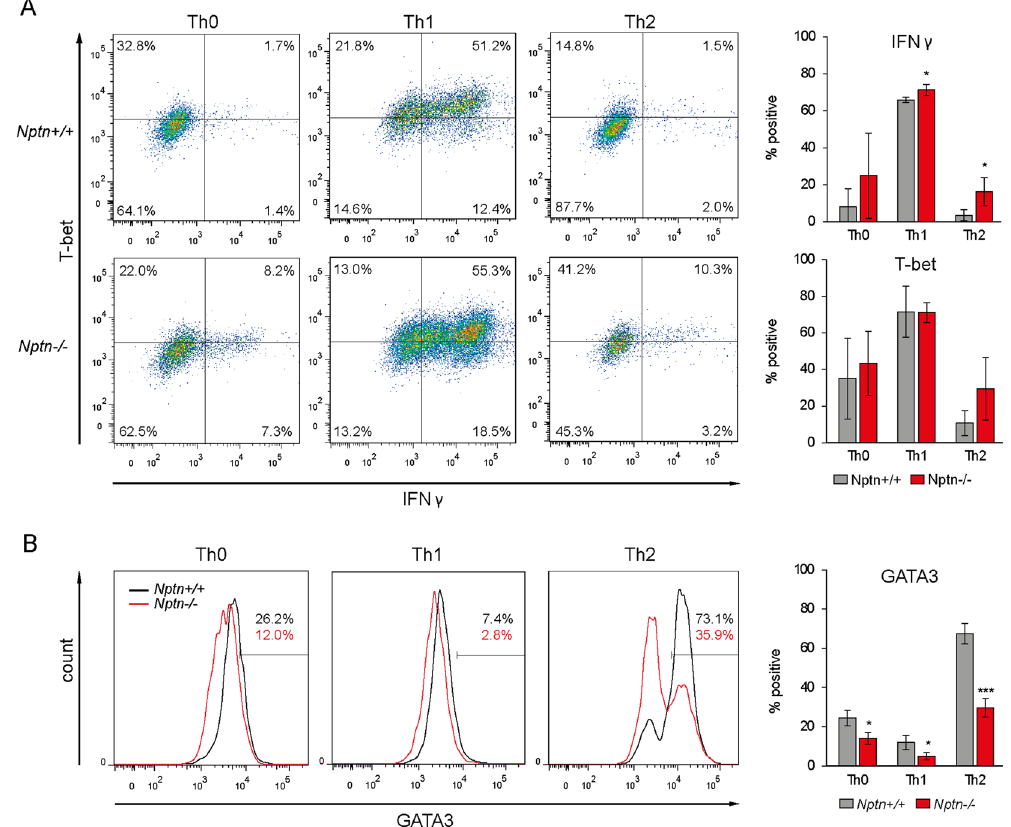
Figure 6. Polarization of Nptn − / − CD4 T cells favors Th1 differentiation. Expression of IFN γ and transcription factors in differentiated T helper cells. Naive CD4 T cells were cultured on immobilized anti-CD3 and anti-CD28 in medium supporting either Th0, Th1, or Th2 differentiation. On day 5 of culture, expression of IFN γ , T-bet or GATA3 was assessed by intracellular FACS staining. ( A ) Representative plots showing IFN γ and T-bet fluorescence under particular differentiation conditions. Mean proportions of IFN γ or T-bet expressing cells ± SD from 4 wt and 3 Nptn − / − mice are shown. ( B ) Representative fluorescence histograms of GATA3 expression. Bar graphs show mean proportions of GATA3 expressing T cells ± SD from 4 wt and 3 Nptn − / − mice for each condition. * p < 0.05, *** p < 0.001, unpaired two-tailed